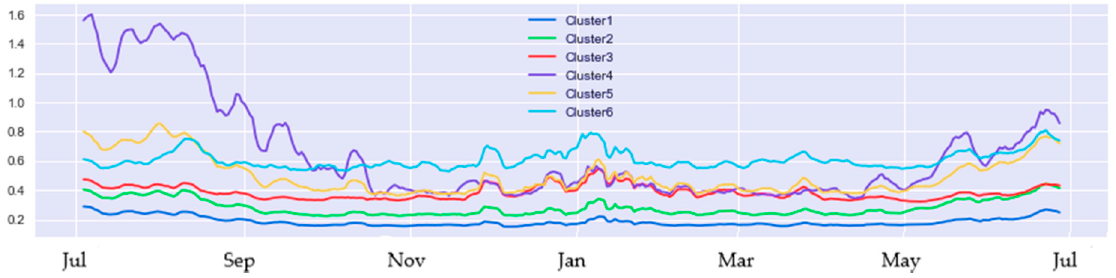
Figure 11. Clusters heterogeneity of electricity demand.